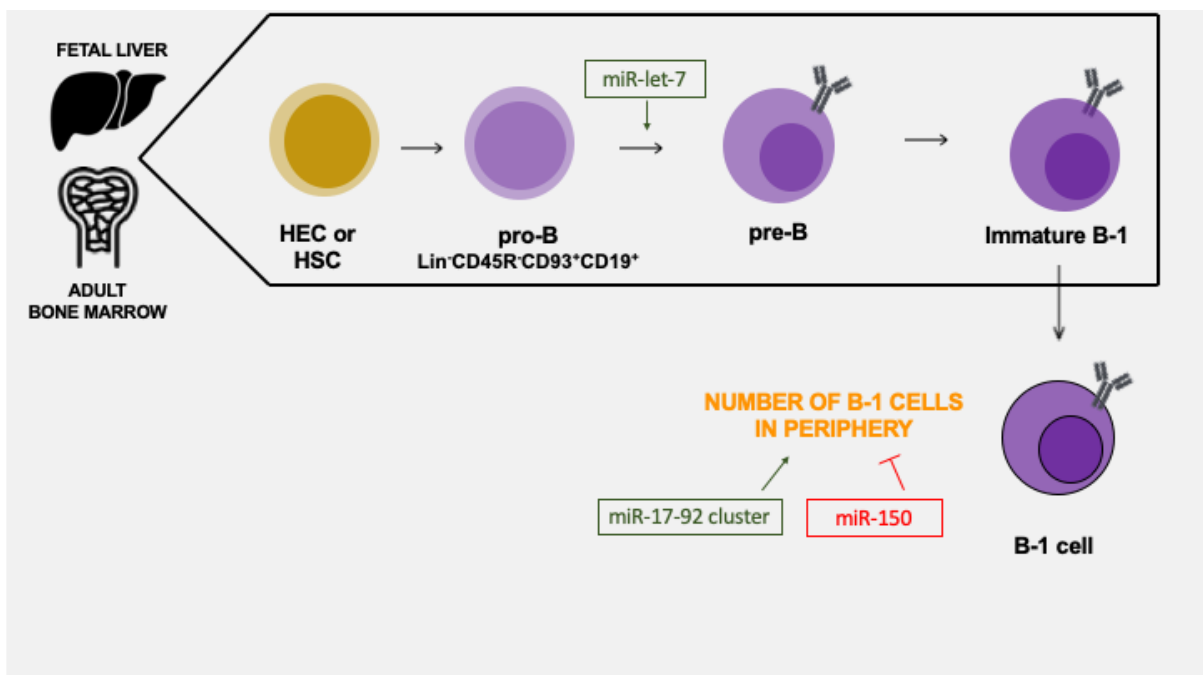
Figure 2. Role of microRNAs in B-1 cell differentiation. A few microRNAs are known to regulate B-1 cell stages by negative control (red) or induction (green). In bone marrow, let-7 interferes in pro-B-to-pre-B differentiation. In the periphery, microRNAs miR-17-92 cluster and miR-150 control B-1 cell quantity. B-1 cell